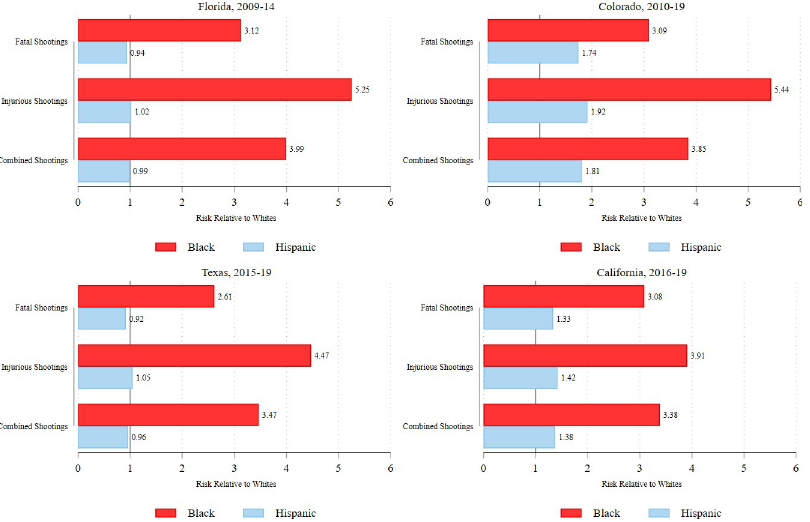
Fig 2. Racial disparities in fatal and injurious police shootings in each state. � Population estimates for FL are 2010– 14 ACS 5-year estimates. Population estimates for CO, TX, and CA are 2015–19 ACS 5-year estimates.